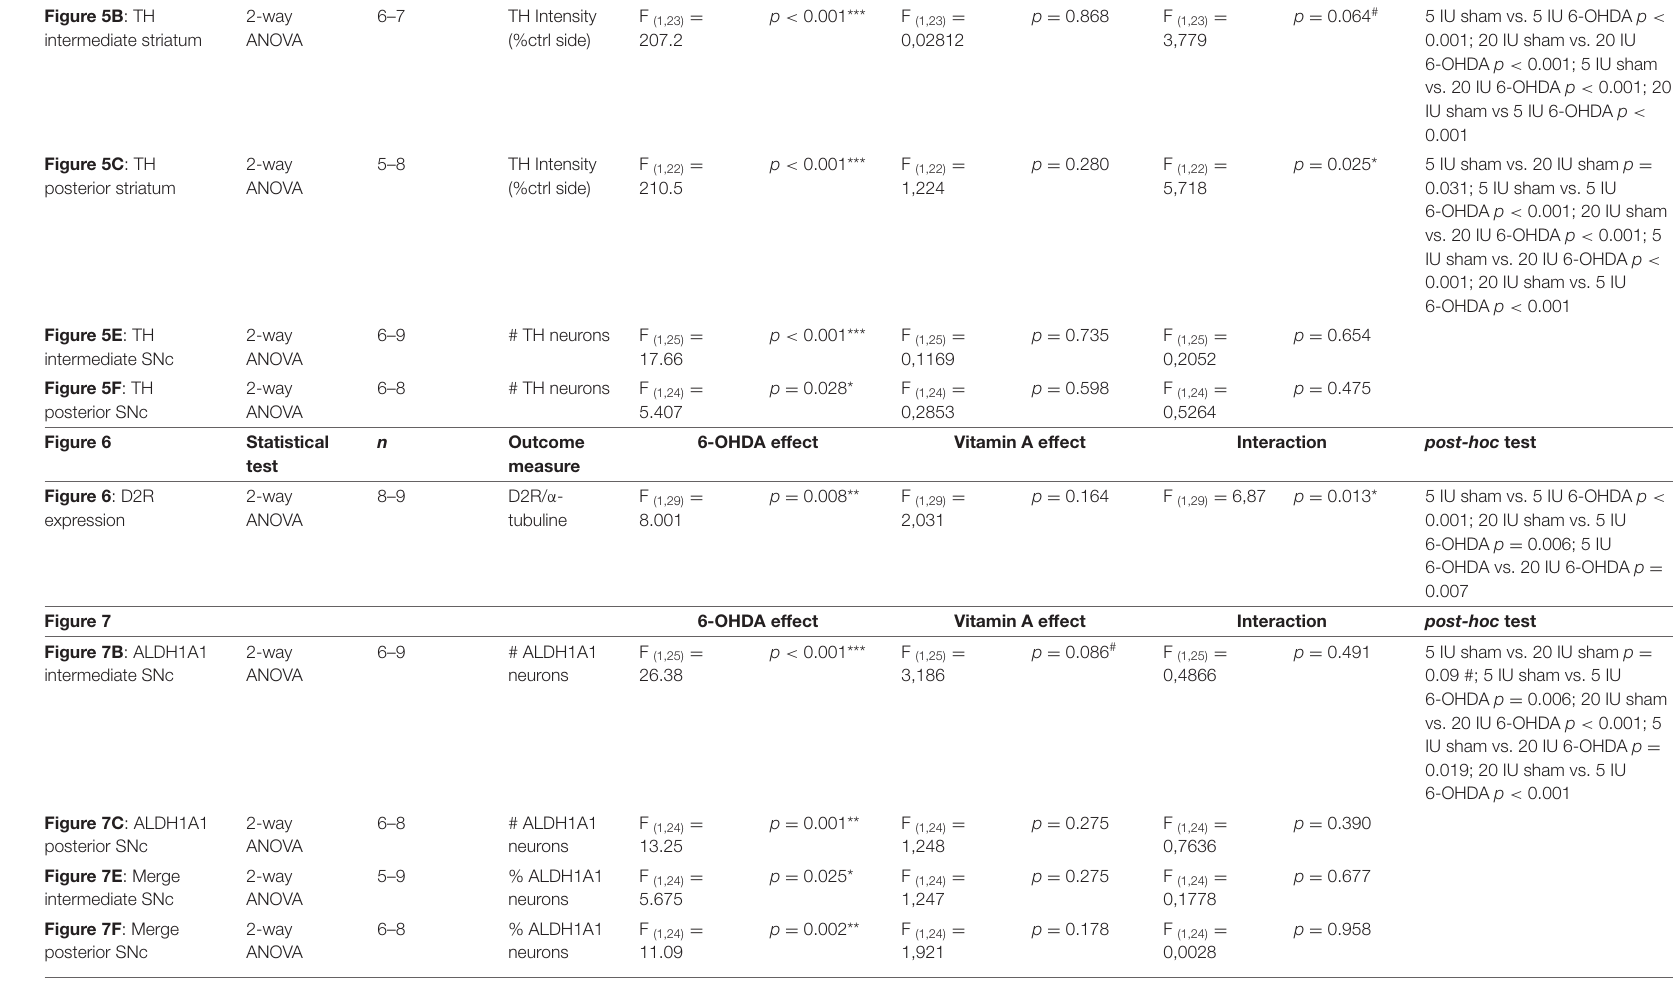
Figure 5B : TH intermediate striatum